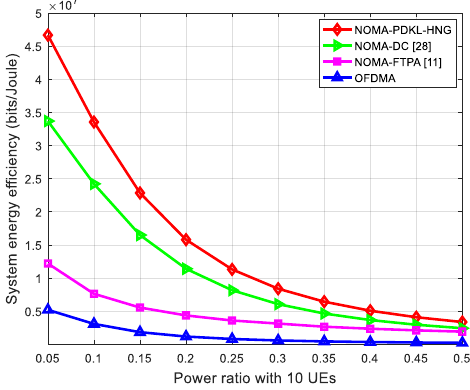
Figure 6. System energy efficiency vs. power ratio with 10 UEs.